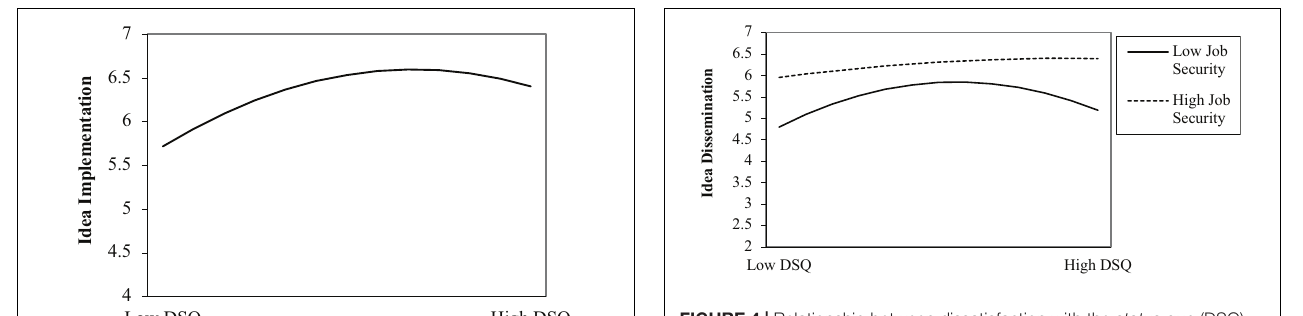
FIGURE 4 | Relationship between dissatisfaction with the status quo (DSQ) and idea dissemination as a function of job security.